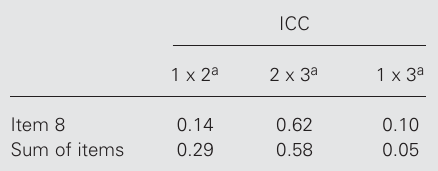
Figure 1. Scores obtained with the Portuguese version of the Abnormal Involuntary Move- ments Scale (AIMS) for control patients (open bars, N = 5) or tardive dyskinesia patients (closed bars, N = 11). Data are reported as means ± SEM scores obtained by one rater who was unaware of the diag- nosis. *P<0.05 compared to control (Student t-